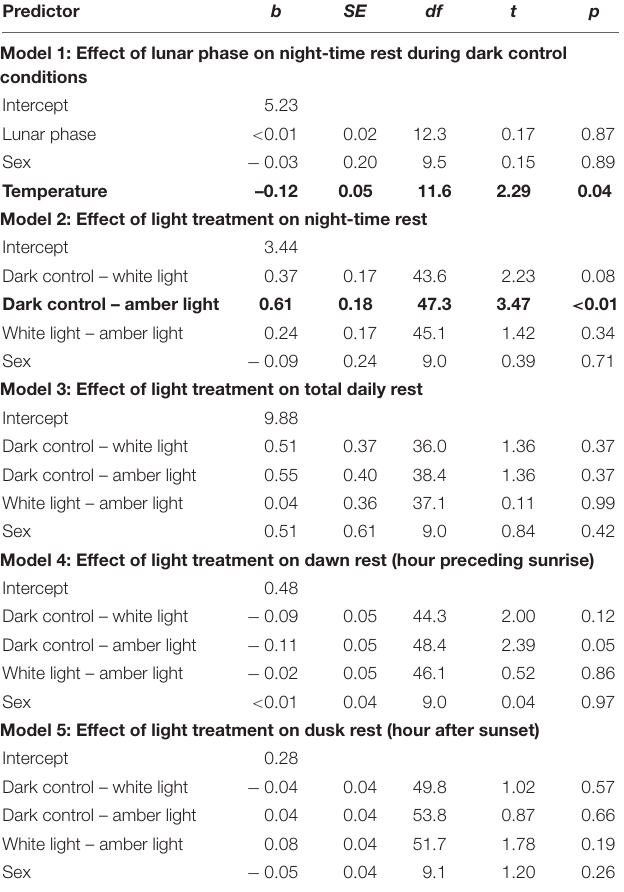
TABLE 1 | Results from linear mixed-effects models for impacts of light at night on time spent resting in black swans (b, unstandardized regression co-efficient; SE, standard error of regression co-efficient; df, degrees of freedom; t, t-ratio; p, p